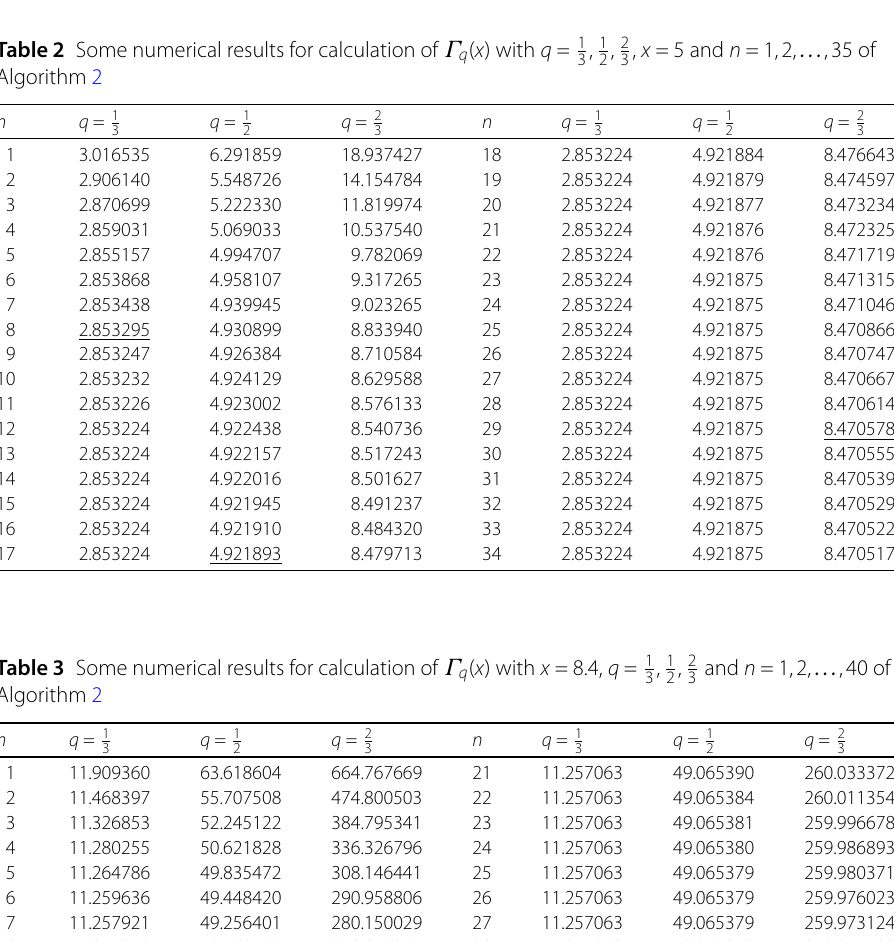
Table 2 Some numerical results for calculation of Γ q ( x ) with q = 1